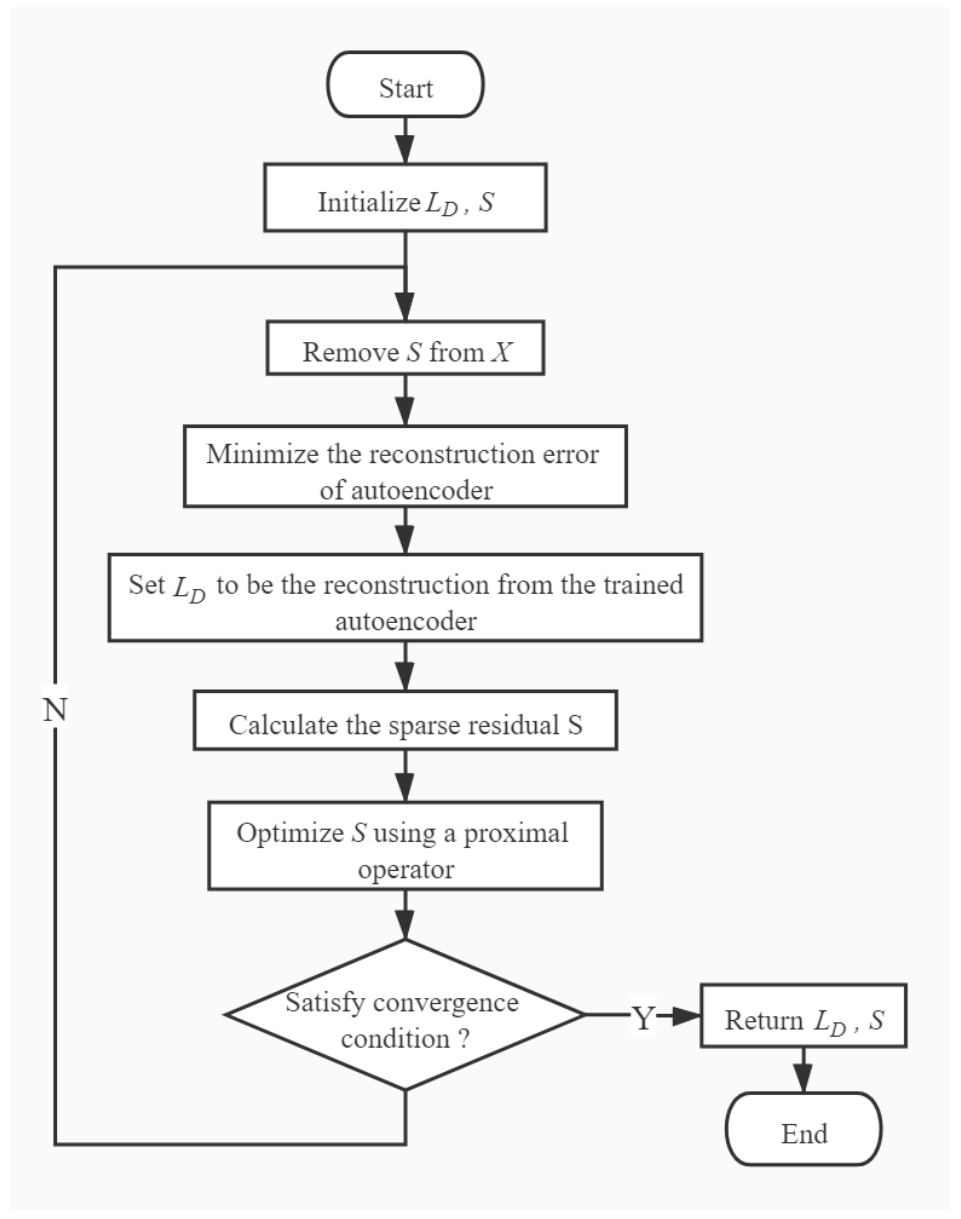
Figure 4. Flowchart of the RDA